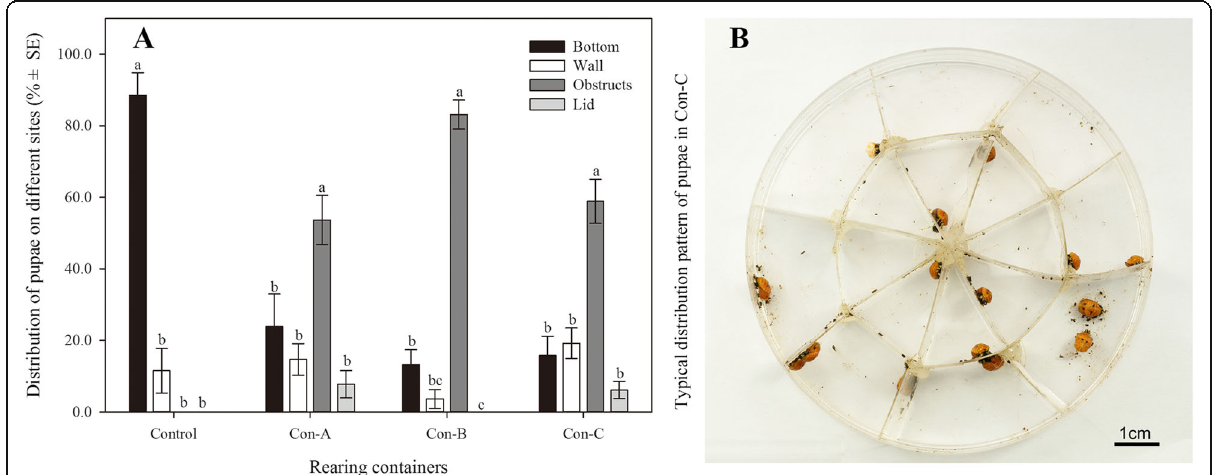
Fig. 3 Distribution of pupae in the four types of rearing units ( A ) and the typical distribution pattern of pupae in the Con-C unit ( B ). Different letters indicated significant differences among the four sites (bottom, wall, and lid of Petri dish, on obstructs) of each type of rearing